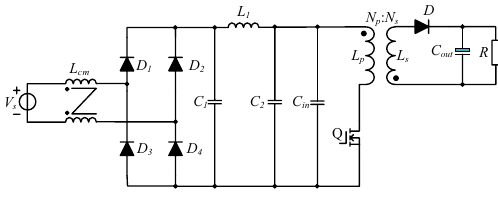
Figure 1. Topology of PD adapter.